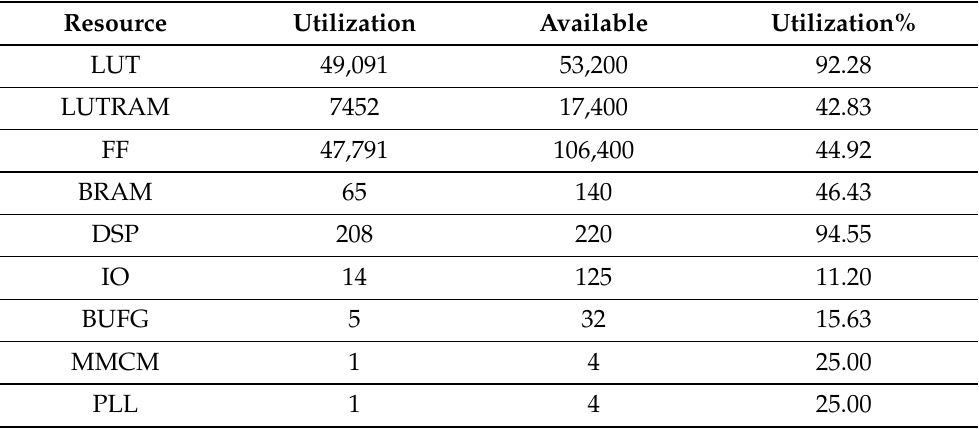
Table 6. Resource usage of the AZUPT implemented